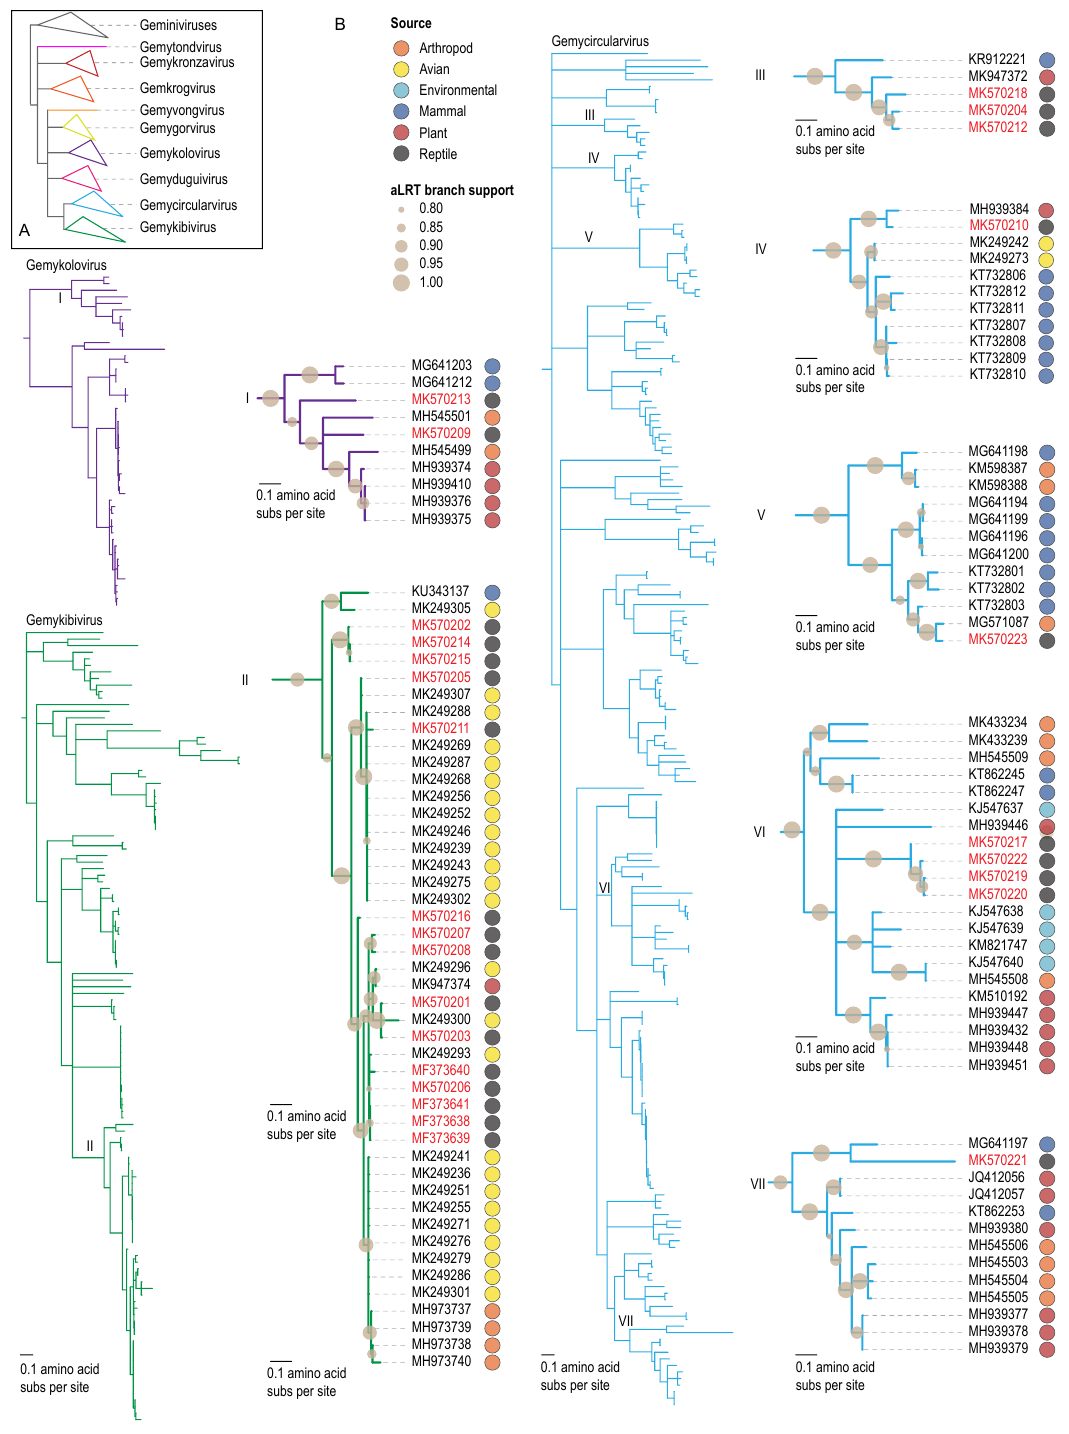
Figure 1. A. Phylogenetic relationship of the Rep protein sequences of genomoviruses with genus level clustering. B . Maximum likelihood phylogenetic trees of the Reps sequences of genomoviruses identified in this study that belong to the genera Gemykolovirus , Gemykibivirus and Gemycircularvirus . For each tree, a detailed view of the clusters that have the Reps from this study is provided to the right of the genus level trees. Next to each accession number the source of the sequence is